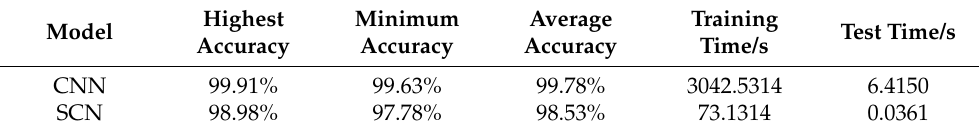
Table 2. Recognition accuracy and average running time of four-classifying models.